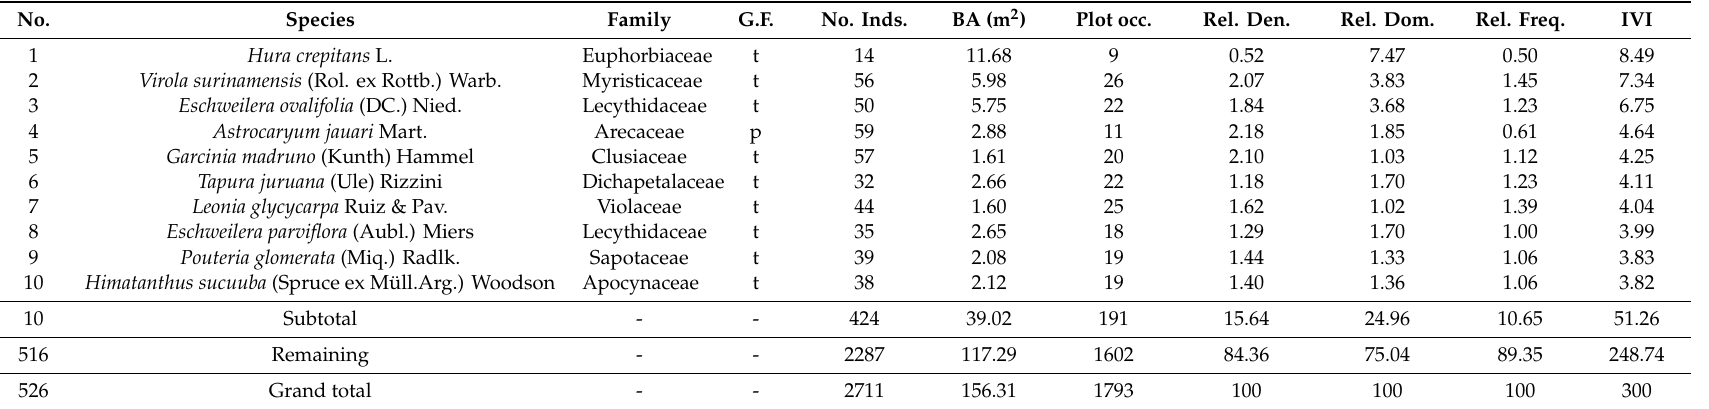
Table 6. The ten most important v á rzea species, listed in descending order of Importance Value Index (IVI). Values are based on all woody plants with species identifications. Growth forms (G.F.) observed for each species are given as t = tree and p = palm. The number of individuals within each species (No. Inds.) and the number of plots in which each species occurs (Plot occ.) are given as counts. Relative density (Rel. Den.), relative dominance (Rel. Dom.) and relative frequency (Rel. Freq.) are given as percentages, where 100 equals 100% (Supplementary Table S2).